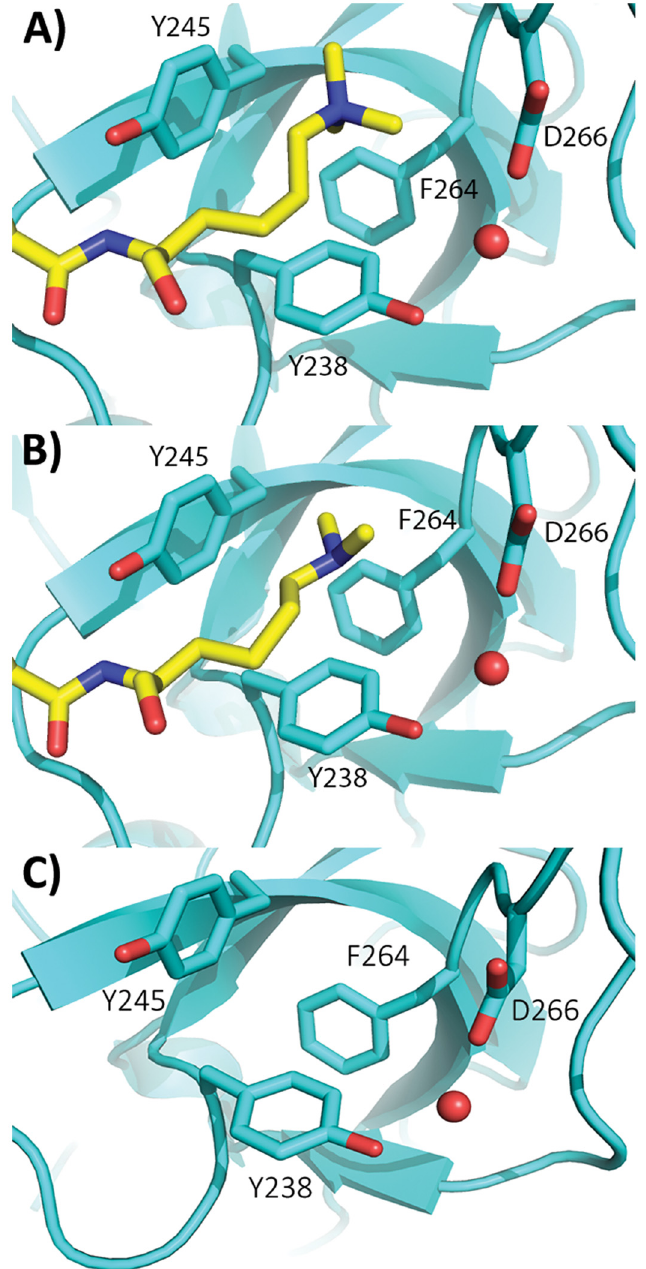
Fig 1. Crystal structure of Sgf29-H3K4me3 (A, PDB ID: 3ME9), Sgf29-H3K4me2 (B, PDB ID: 3MET) and the apo form of Sgf29 (C, PDB ID: 3MEW). Sgf29 and H3K4me2/3 histone peptide are shown in cyan and yellow,